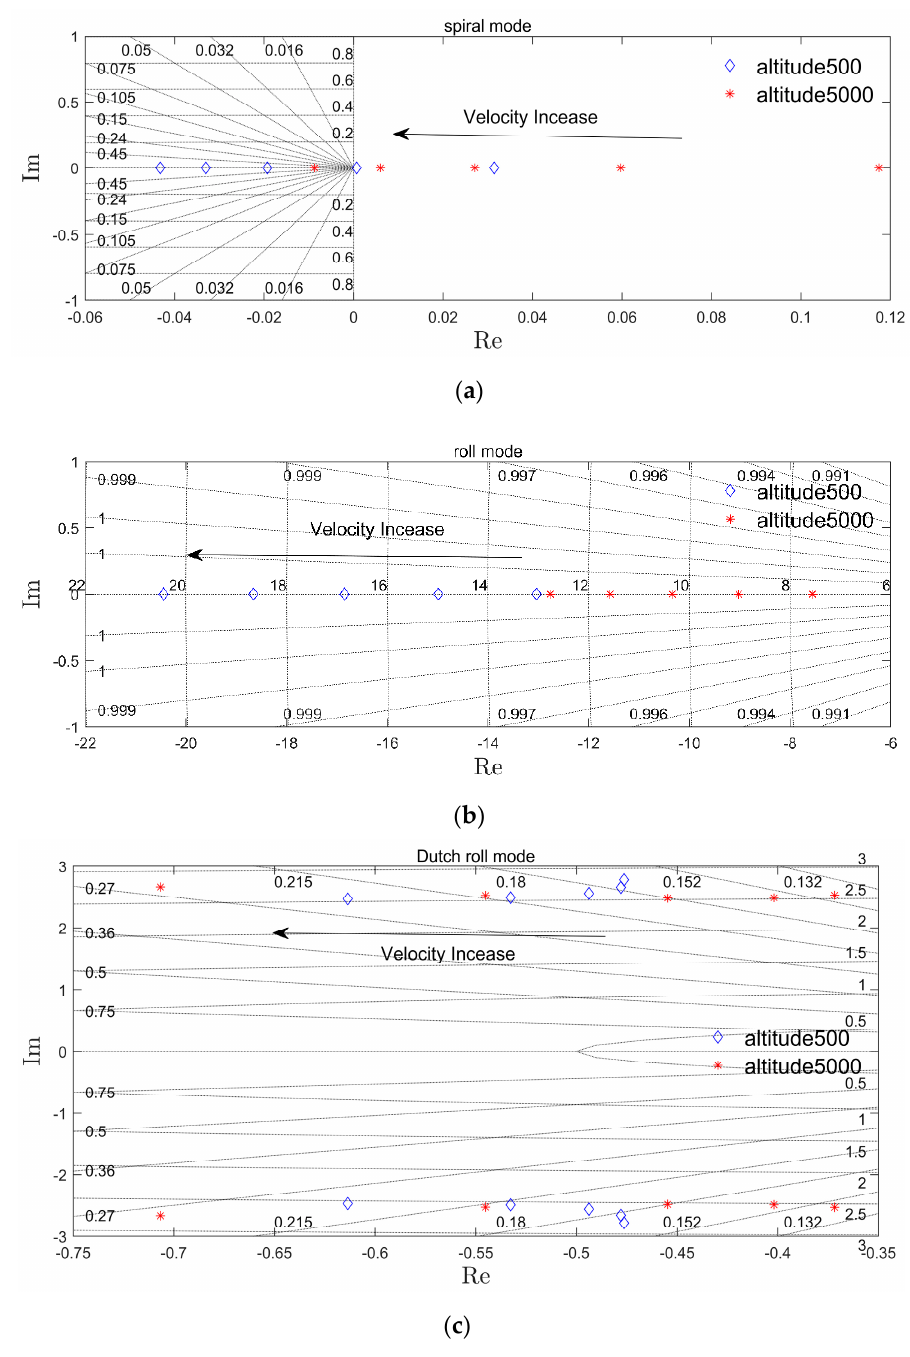
Figure 11. The change of system characteristic roots with different altitude and speed in lateral-directional mode. ( a ) Spiral mode. ( b ) Roll mode. ( c ) Dutch roll mode. lateral-directional mode. ( a ) Spiral mode. ( b ) Roll mode. ( c ) Dutch roll